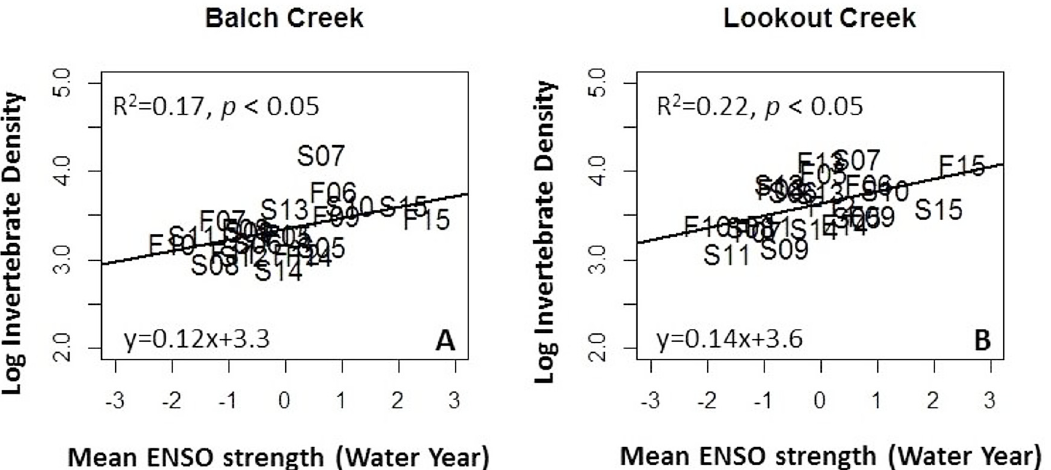
Fig 7. Linear models and R 2 values of invertebrate density as a function of water-year ENSO MEI at Balch Creek (Panel A) and Lookout Creek (Panel B). Sample points are represented by text with season and year